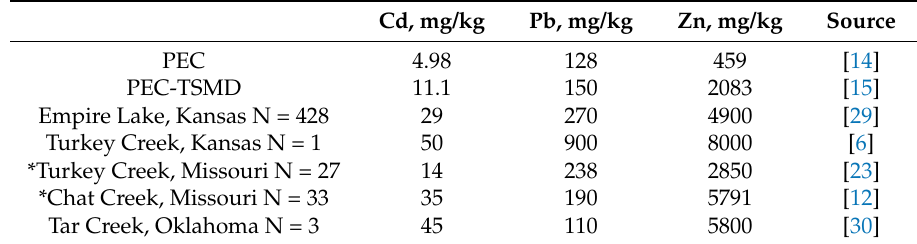
Table 1. Probable effect concentration (PEC), TSMD-specific PEC, and median of total (and pseudo-total*) metal concentrations in stream sediments reported in the literature for contaminated sites within the Tri-State Mining District